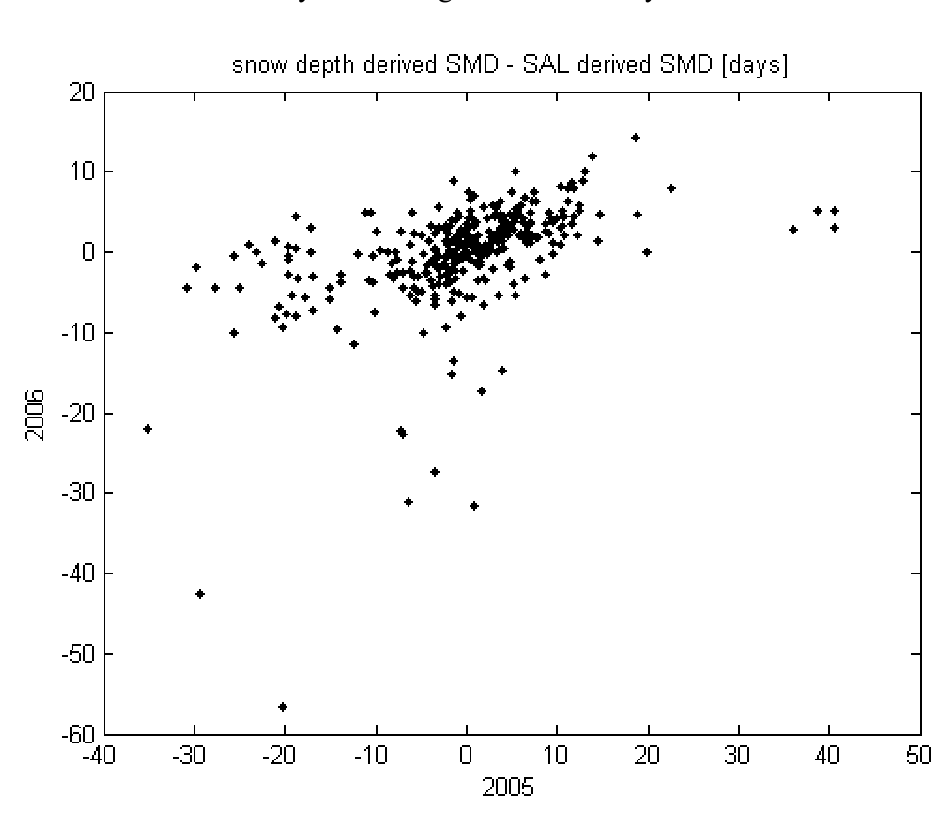
Figure 4. The difference between snow-depth-derived SMD and SAL-derived SMD at Finnish weather stations in the year 2005 against that in the year 2006.